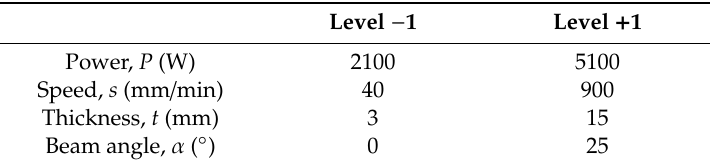
Table 1. Factor levels for design and welding